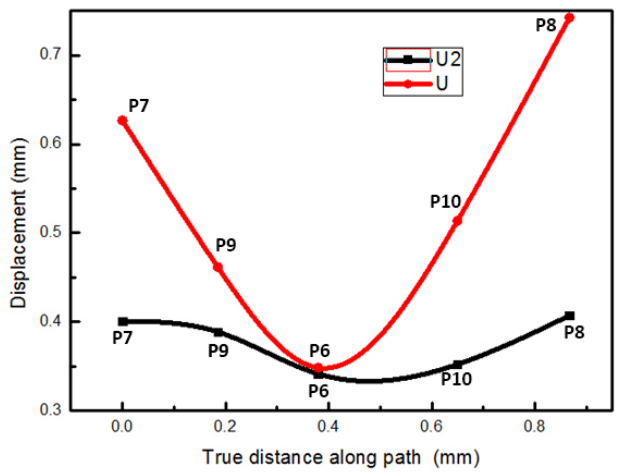
Figure 7. The axial displacement-true path curve of the characteristic point (P6–P10).